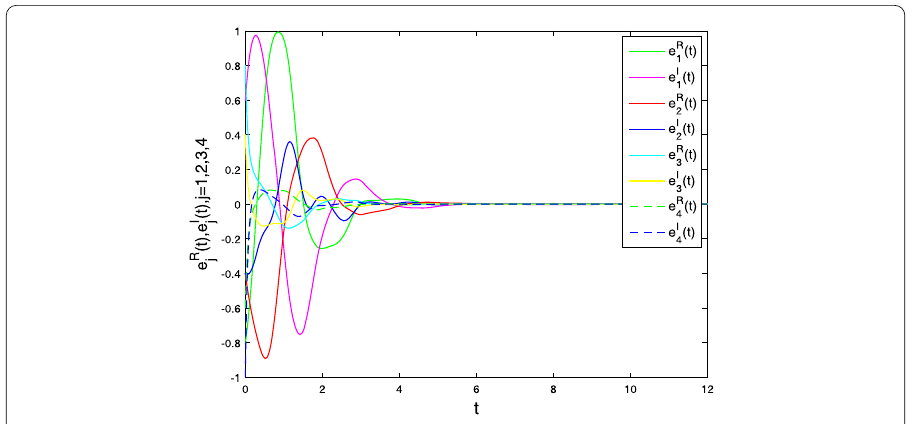
Figure 6 Time response curves of errors e R j ( t ) and e I j ( t ) under the adaptive controller (23)